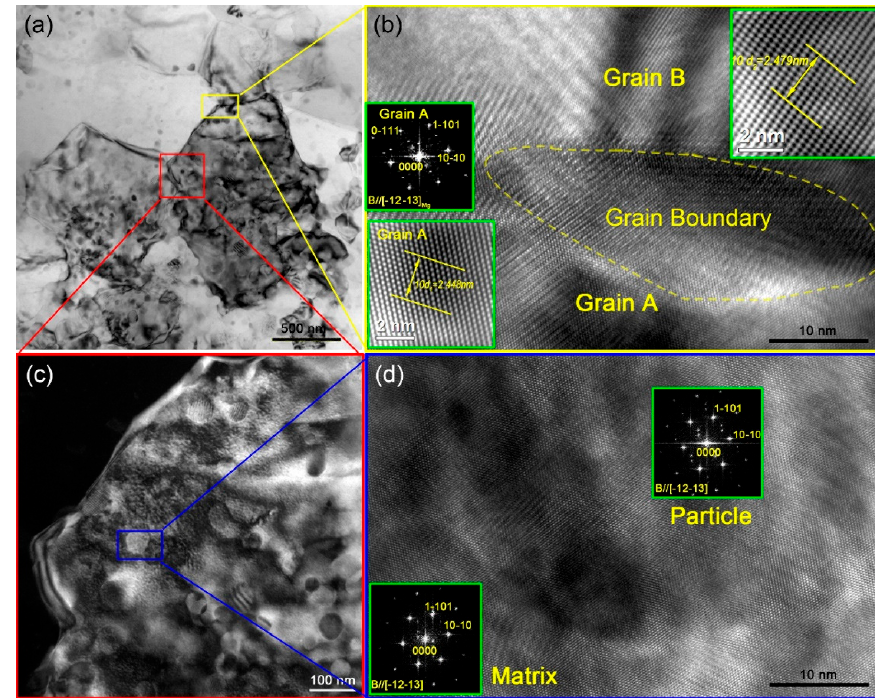
Figure 6. ( a ) A bright field TEM micrograph of the tensile sample of the as-extruded AZXSE91000 alloy at 200 °C; ( b ) the high resolution transmission electron microscopy (HRTEM) micrograph corresponding to the yellow rectangle zone in Figure 6a; ( c ) the enlarged dark field TEM micrograph corresponding to the red rectangle zone in Figure 6a and ( d ) the HRTEM micrograph corresponding to the blue rectangle zone in Figure 6c.